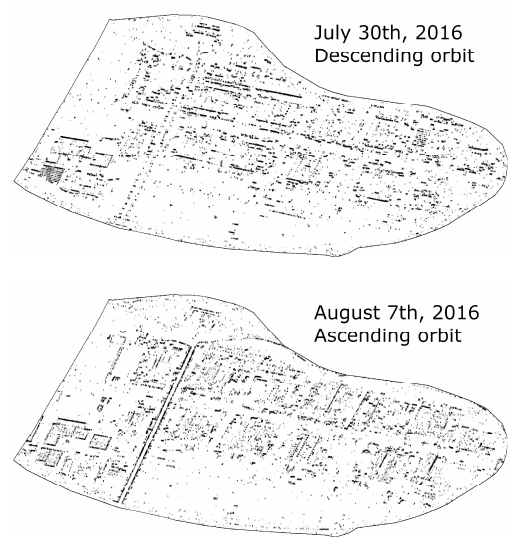
Figure 4. Comparison of the detected coherent scatterers for two images acquired within a week from two different orbits.